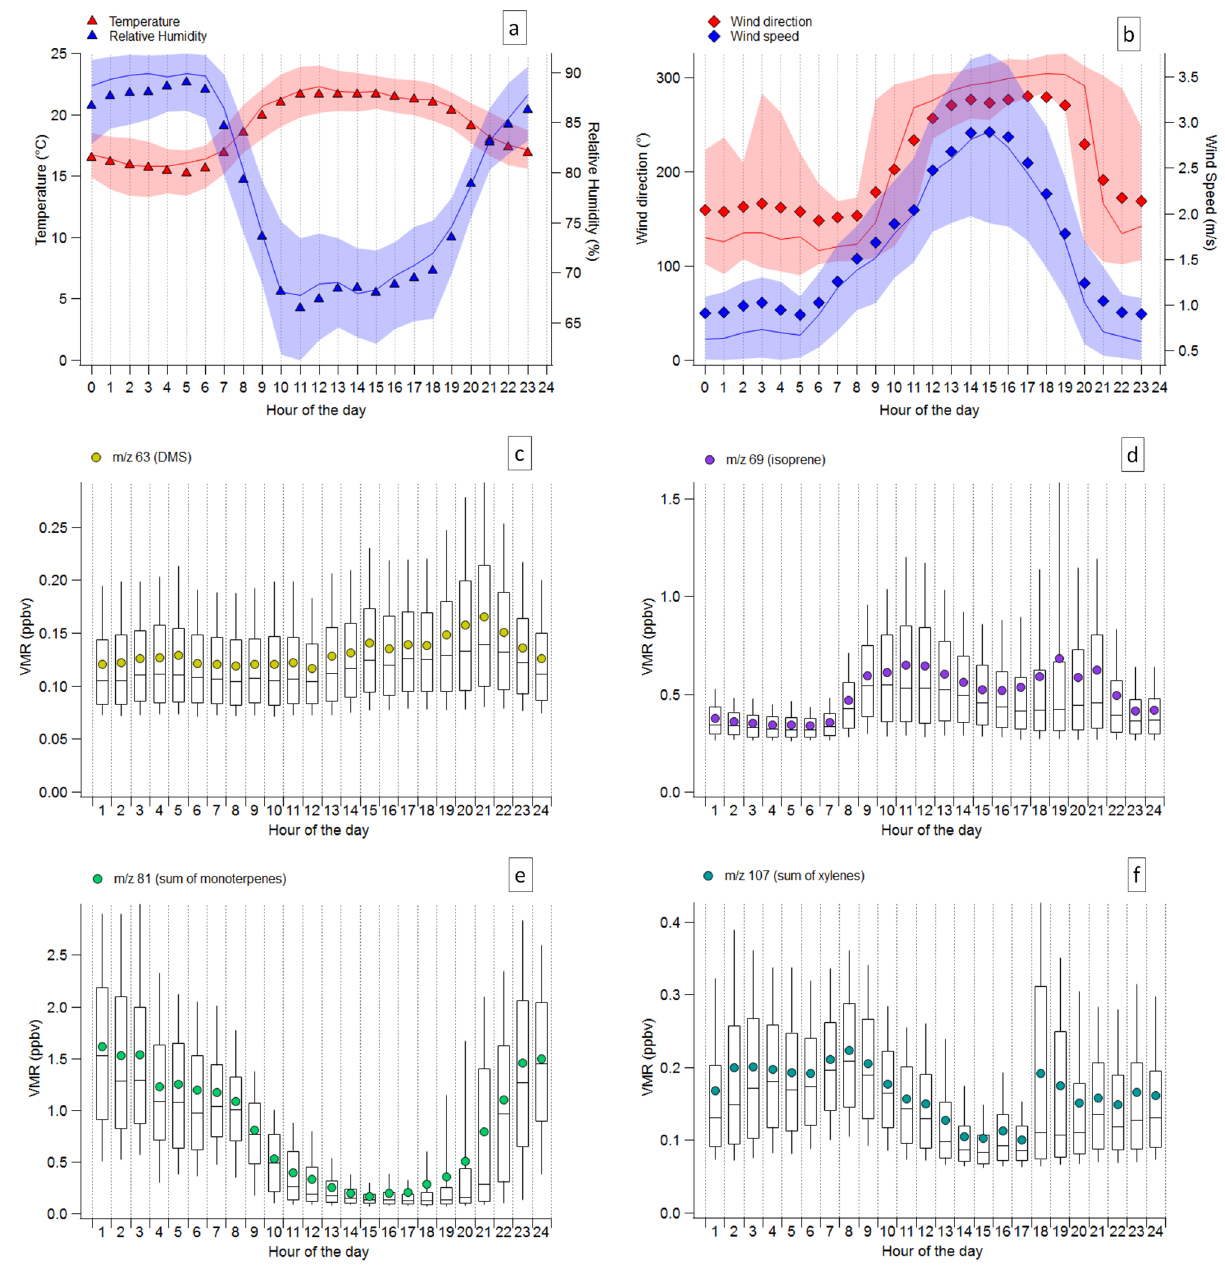
Figure 2. Diel cycle of meteorological parameters ( a , b ) and measured VOCs ( c – f ). The volumetric mixing ratio (VMR) of the volatile organic compounds are reported as their measured mass fragment by PTR-MS: m/z 63 ( c ), m/z 69 ( d ), m/z 81 ( e ) and m/z 107 ( f ); identified respectively as dimethyl sulphide ( c ), isoprene ( d ), sum of monoterpenes ( e ) and sum of xylenes ( f ). Meteorological parameters are plotted as mean campaign values (marker), median (line) and interquartile range (shaded area). VOC box plots report mean campaign values (marker), median (line), interquartile range (box) and 10th and 90th percentiles